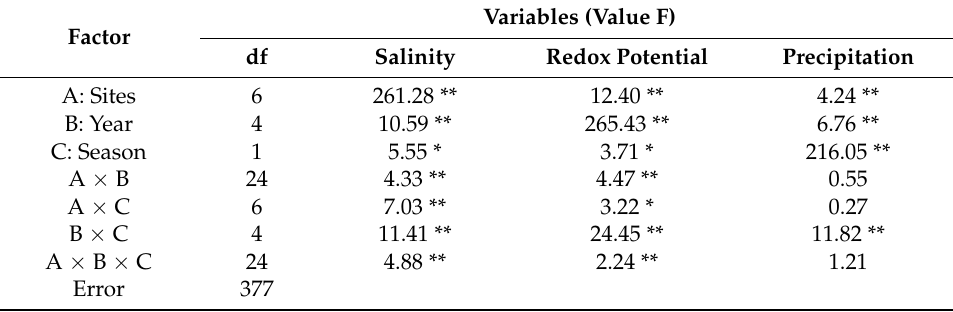
Table 2. Factorial ANOVA (three-factor) for ( A ) sites, ( B ) years, and ( C ) seasons for salinity, redox potential, and precipitation in seven mangrove forests along the coast of Campeche (2009–2010 and 2014–2016).